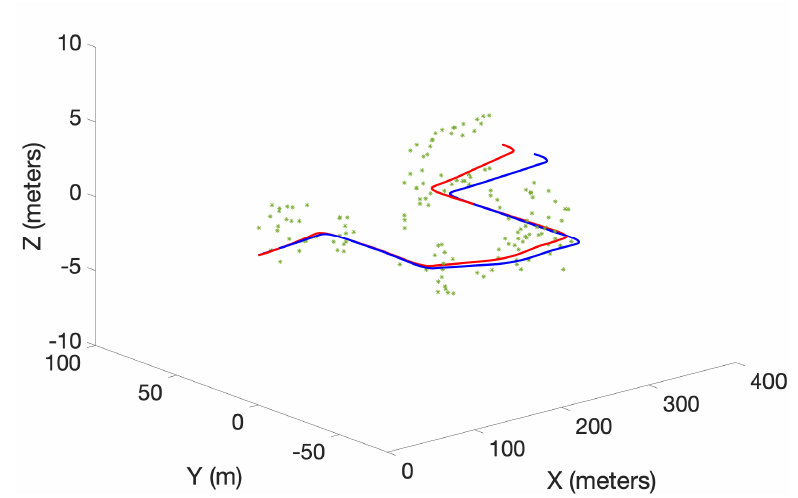
Figure 7. The estimated map (green) and the trajectory (red) using LMB-SLAM with ground truth trajectory (blue).